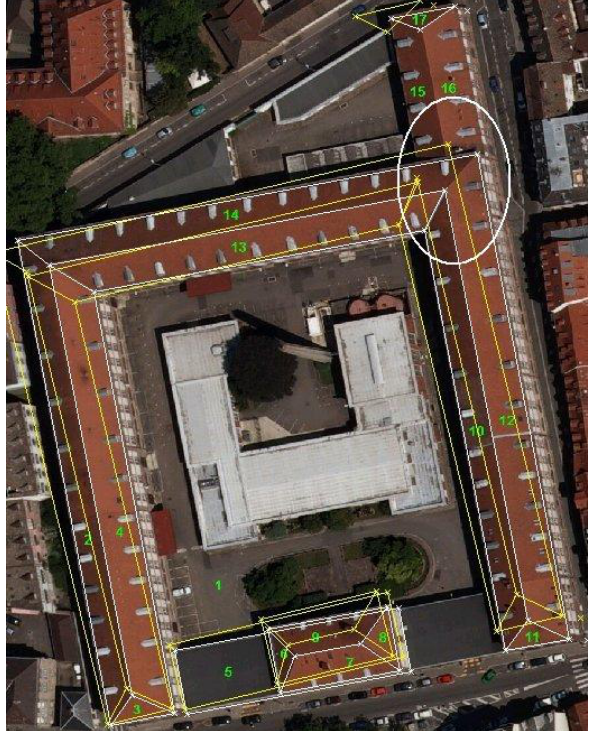
Figure 6. Wireframes of initial model and optimized